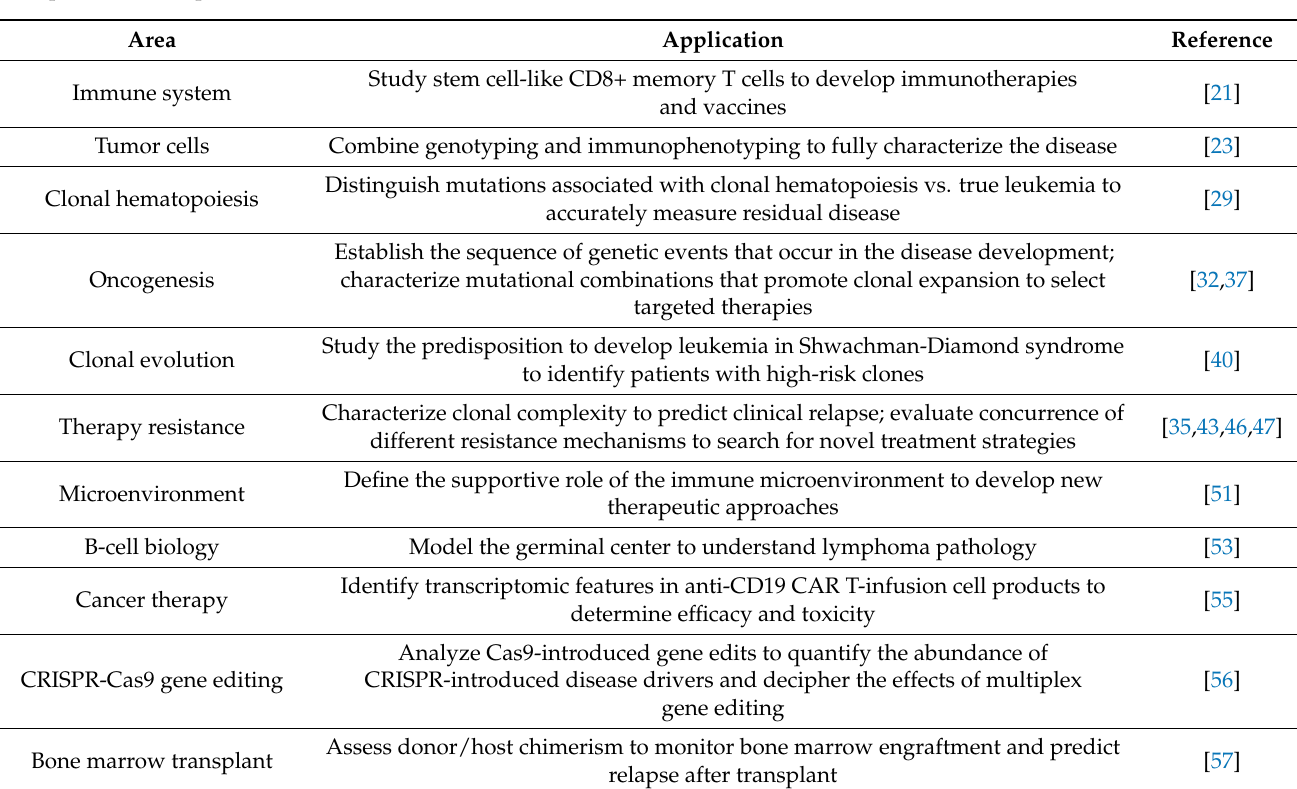
Table 1. Summary of the main applications of single-cell technologies in different areas of hematology. CAR T, chimeric antigen receptor T-cell; Cas9, CRISPR-associated endonuclease Cas9; CRISPR, clustered regularly interspaced short palindromic